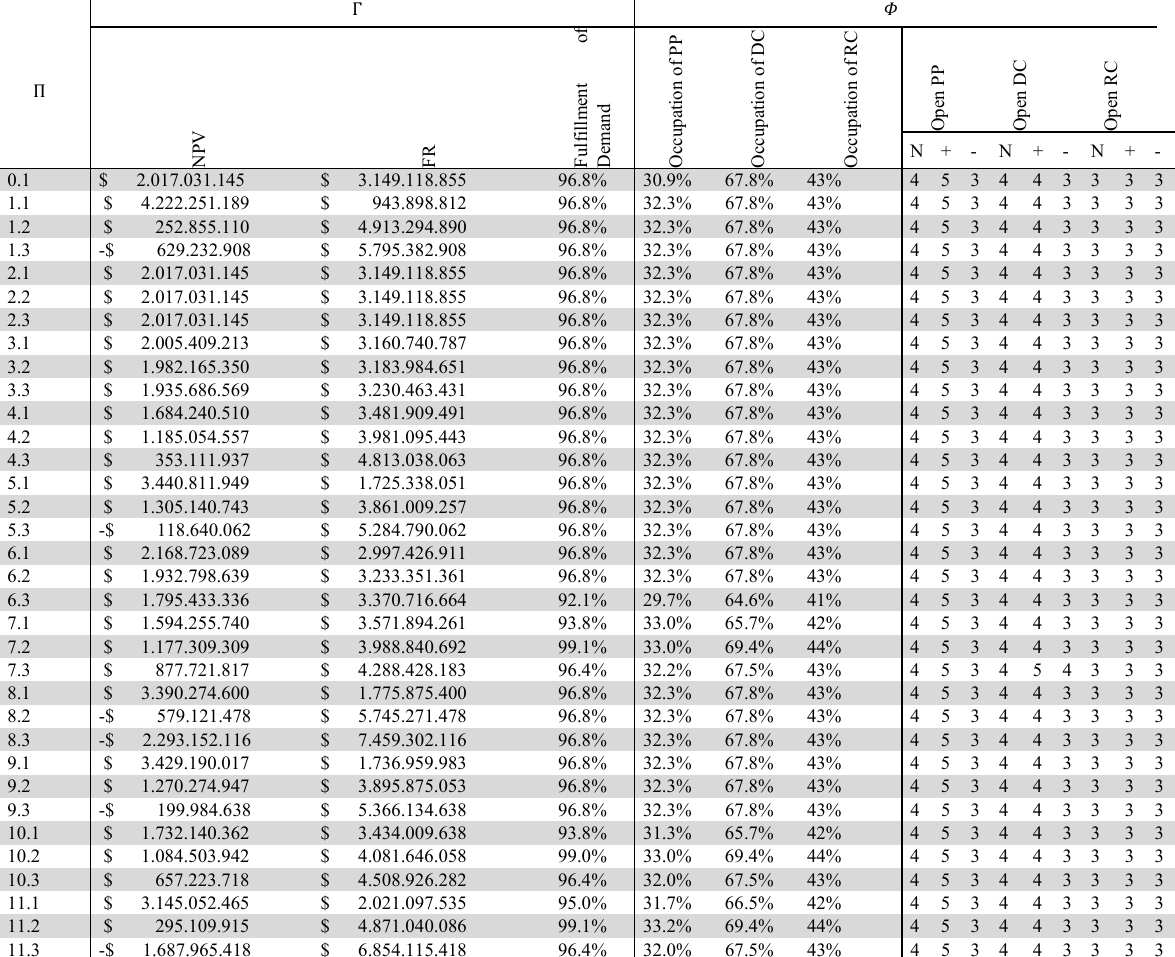
Impact of disturbances on supply chain